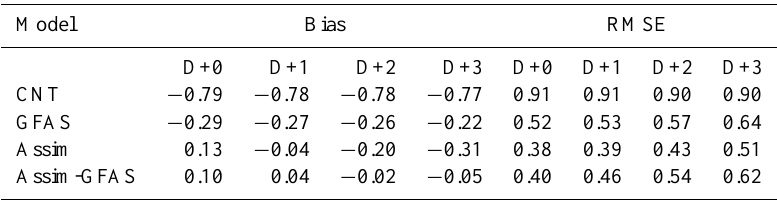
Table 6. Mean bias and RMSE of modeled total CO columns (units 10 18 moleccm − 2 ) compared to MOPITT V4 observations over western Russia between 20 July and 15 August, as function of the hindcast day.